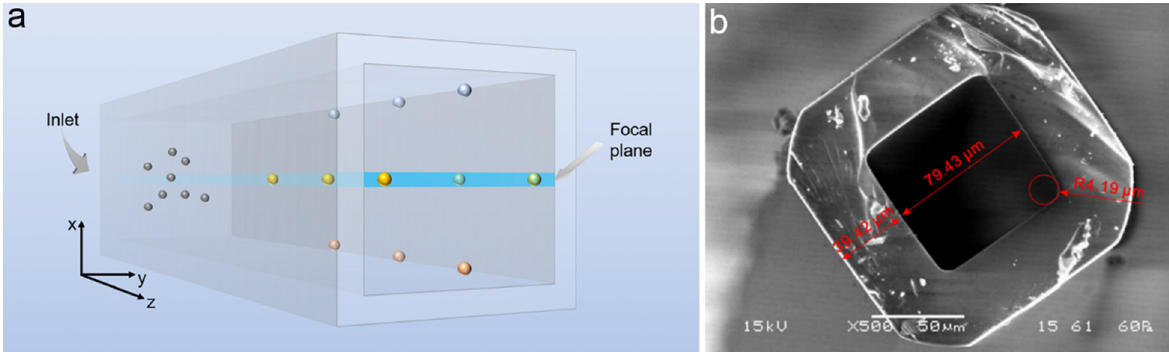
Figure 1. Scheme of the experimental setup. ( a ) Schematical illustration of particles flowing in the microchannel. ( b ) Scanning electron microscopy (SEM) image of the microchannel’s cross-section.